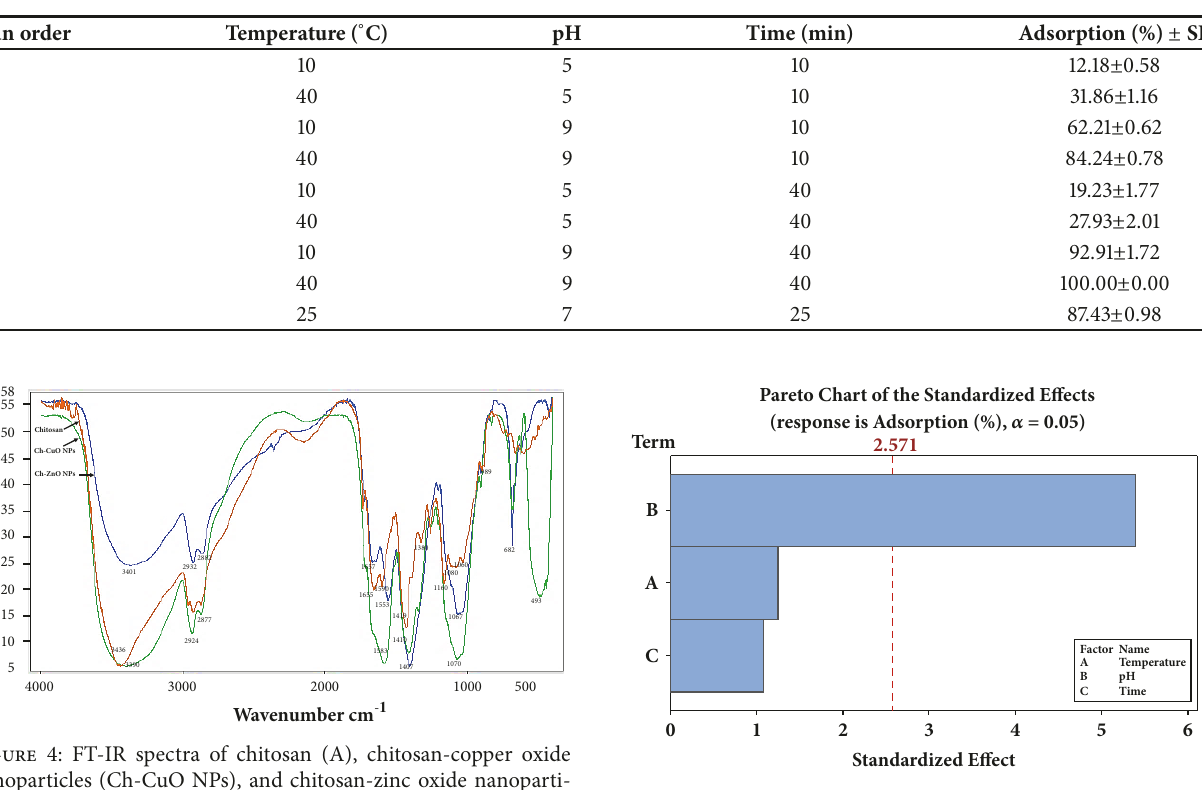
Table2:ExperimentaldesignusingMinitabsoftwareandstandardizedeffectsoftemperature,pH,andtimeontheadsorptionofimidacloprid insecticide at 25mg/L on Ch-CuO NPs.